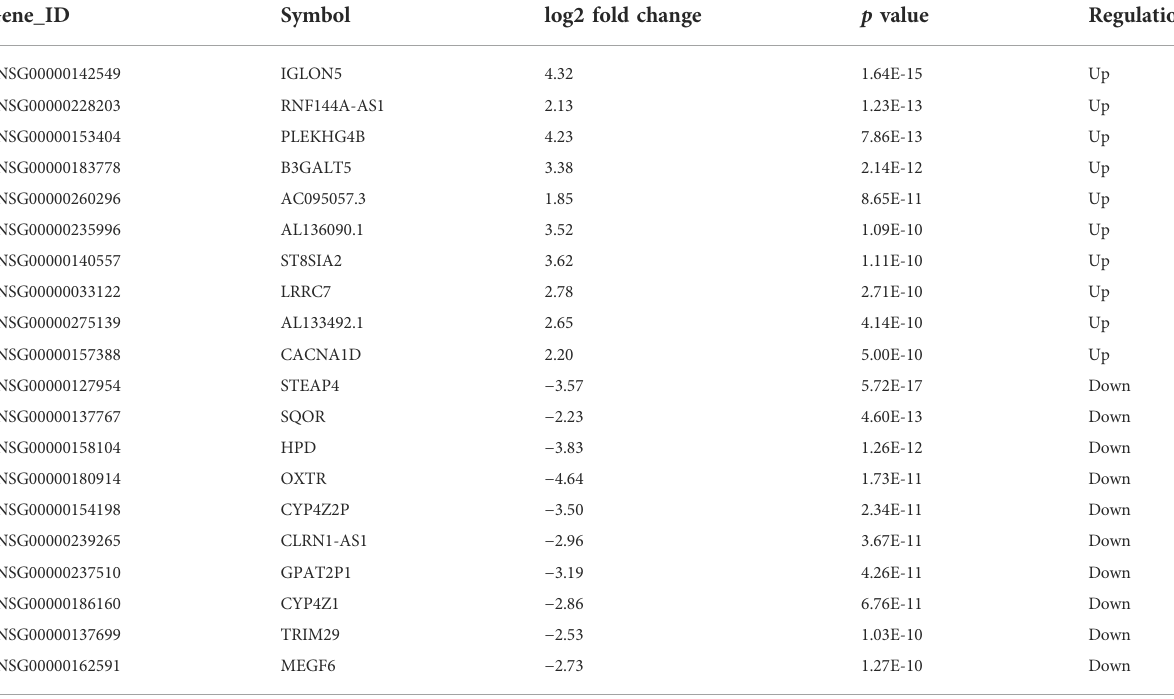
TABLE 1 Top 10 upregulated and downregulated DEmRNAs in uterine leiomyomas.